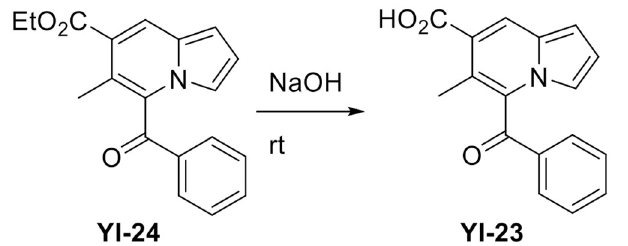
Fig 9. A scheme of synthesizing